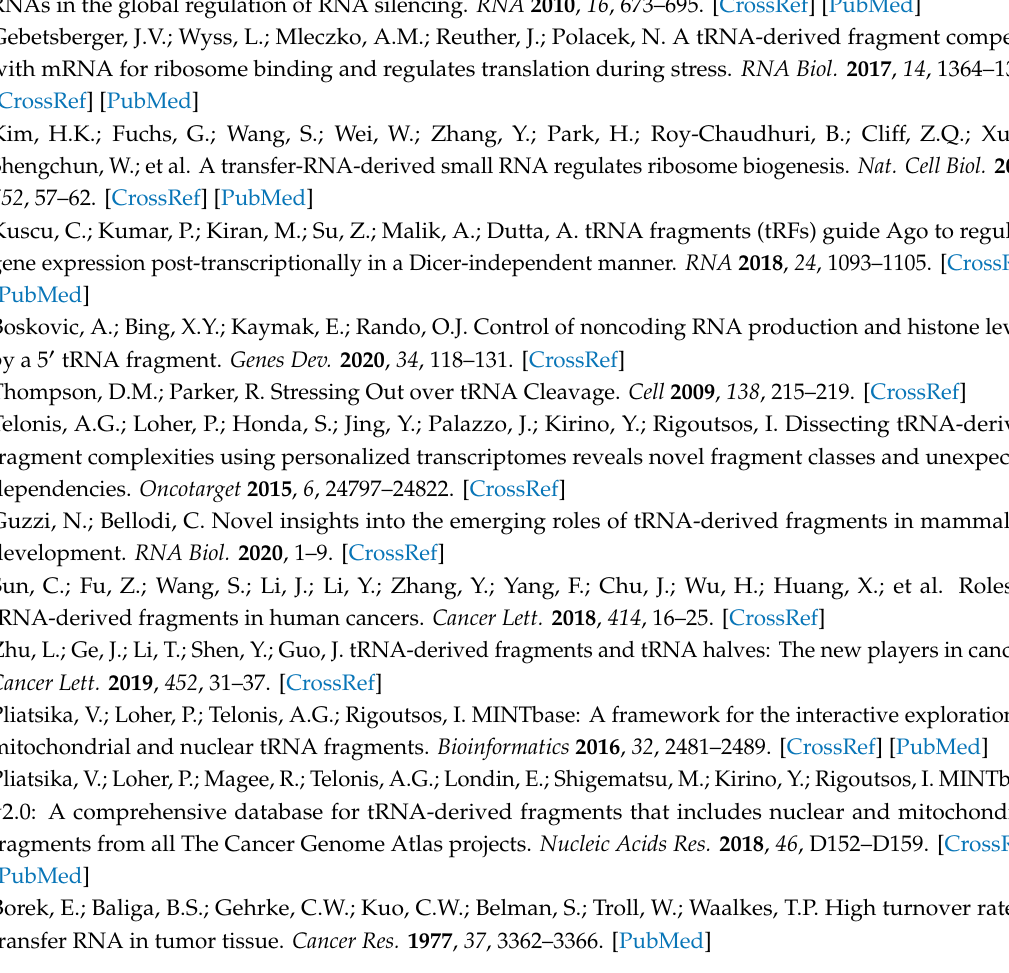
Table S1. Clinical data on healthy controls and patients with SCCOT (our clinical samples), Table S2. Genomic Table S4. tRF-20 levels (RPM) in di ff erent SCCHN subtypes, Figure S1. ROC curve showing the sensitivity and specificity of tRF-20 in predicting patient overall